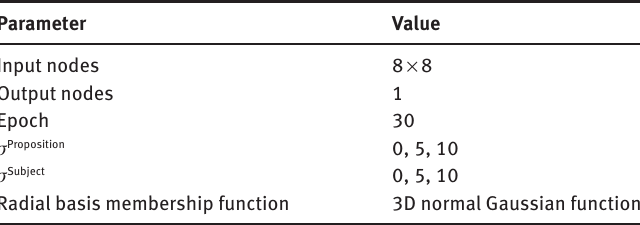
Table 4: Values of Parameters of the RBF Neural Network and Distance Calculation Module. Parameter